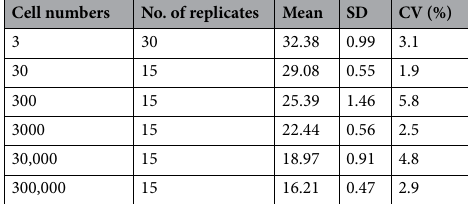
Table 3. Precision of assay as measured using dilutions of crude lysates of 8E5 cells.